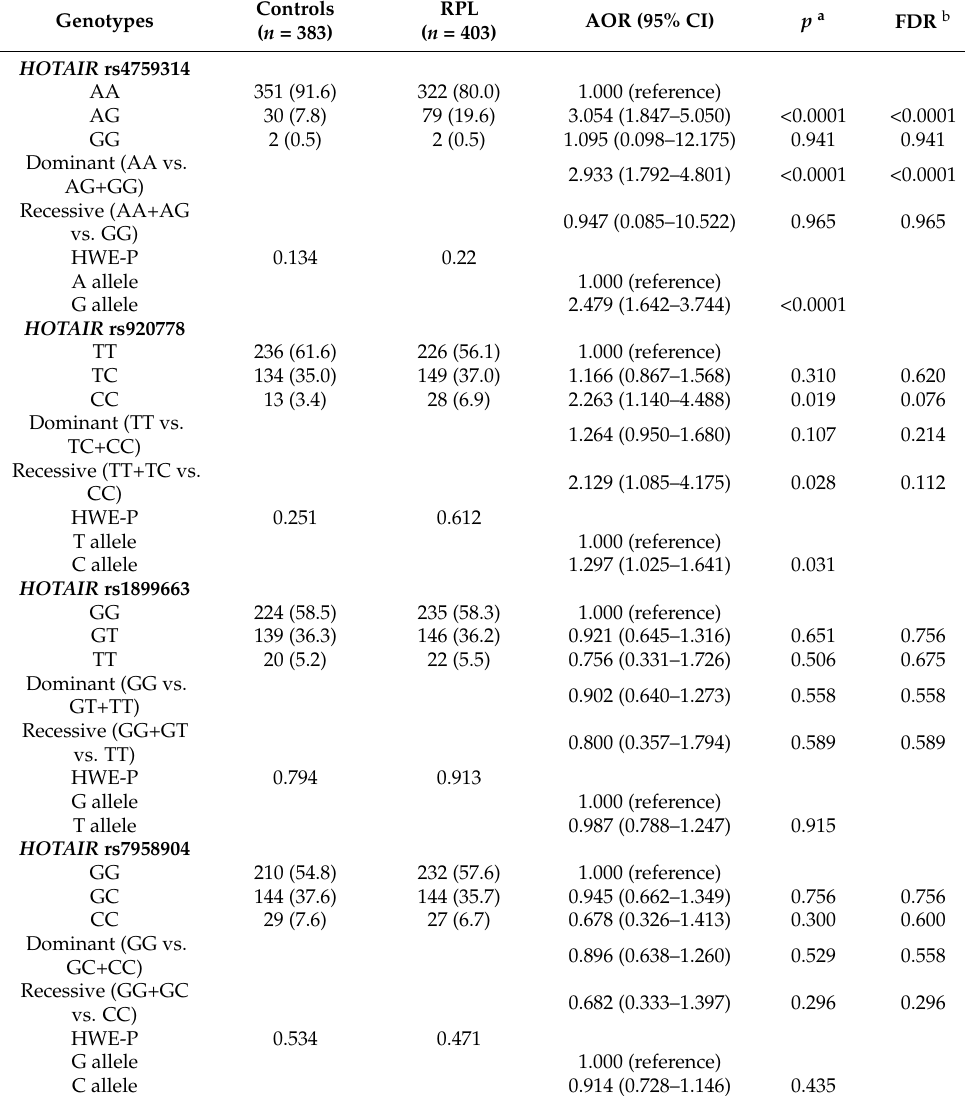
Table 2. Comparison of genotype frequencies and AOR values of polymorphism between the RPL and control subjects.